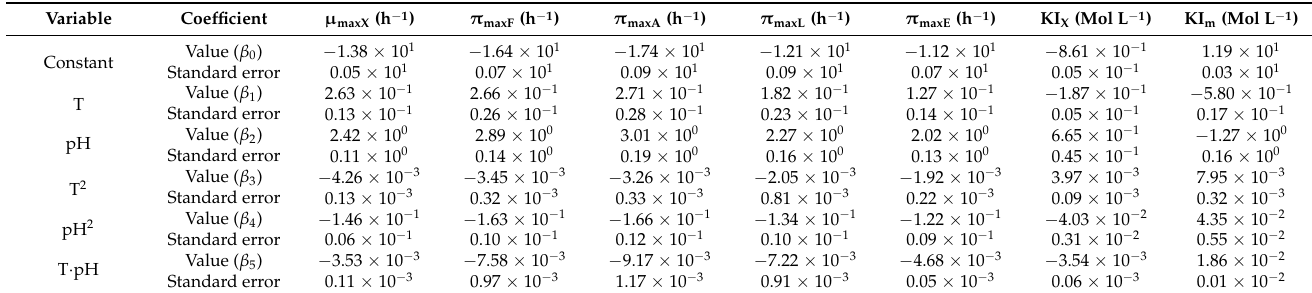
Table A2. Response surface coefficients fitted to experimental data by multiple regression.